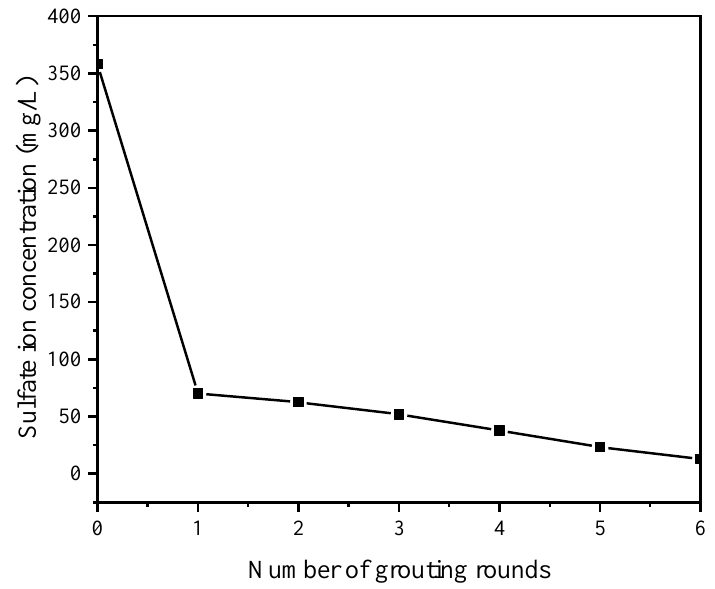
Figure 5. SO 42 − content variation in samples with 0 – 6 rounds of (0 represents the control group).